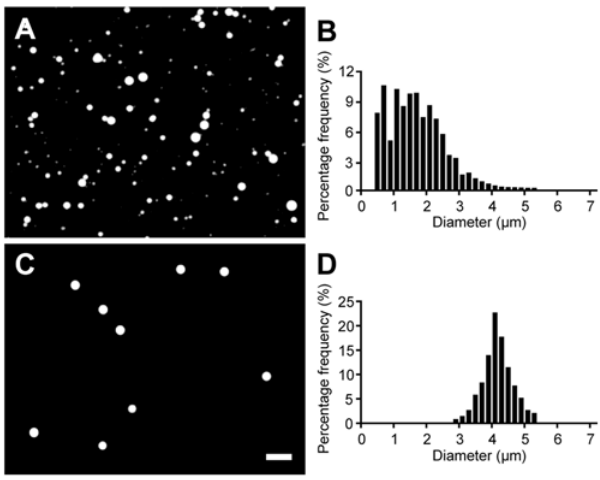
Figure 2. Preparation of large monodisperse oleate vesicles. (A) Oleate vesicles (containing 2 mM HPTS, in 0.2 M Na-bicine, pH 8.5) after being extruded through 5- m m-diameter pores, and (B) the correspond- ing size distribution, shown as percent per 0.2 m m bin (vesicles between 0–0.4 m m in diameter were not counted). (C) After 12 rounds of dialysis using membranes with 3- m m-diameter pores, and (D) the correspond- ing size distribution. Scale bar, 10 m m.